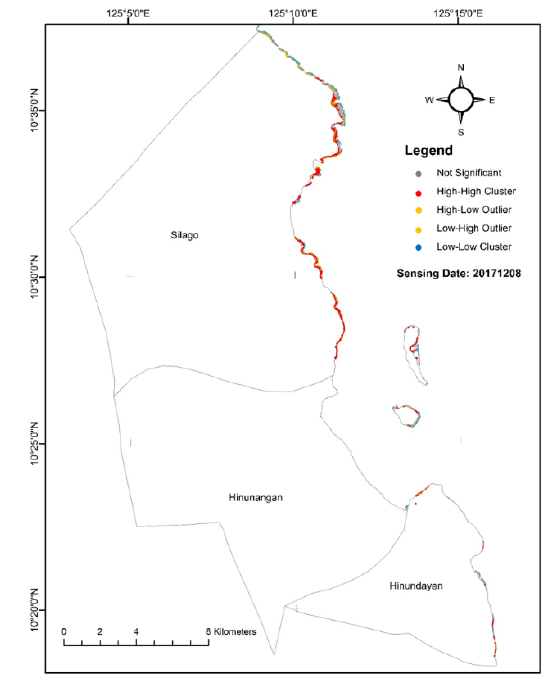
Figure 11. Cluster & Outlier Analysis of Sargassum